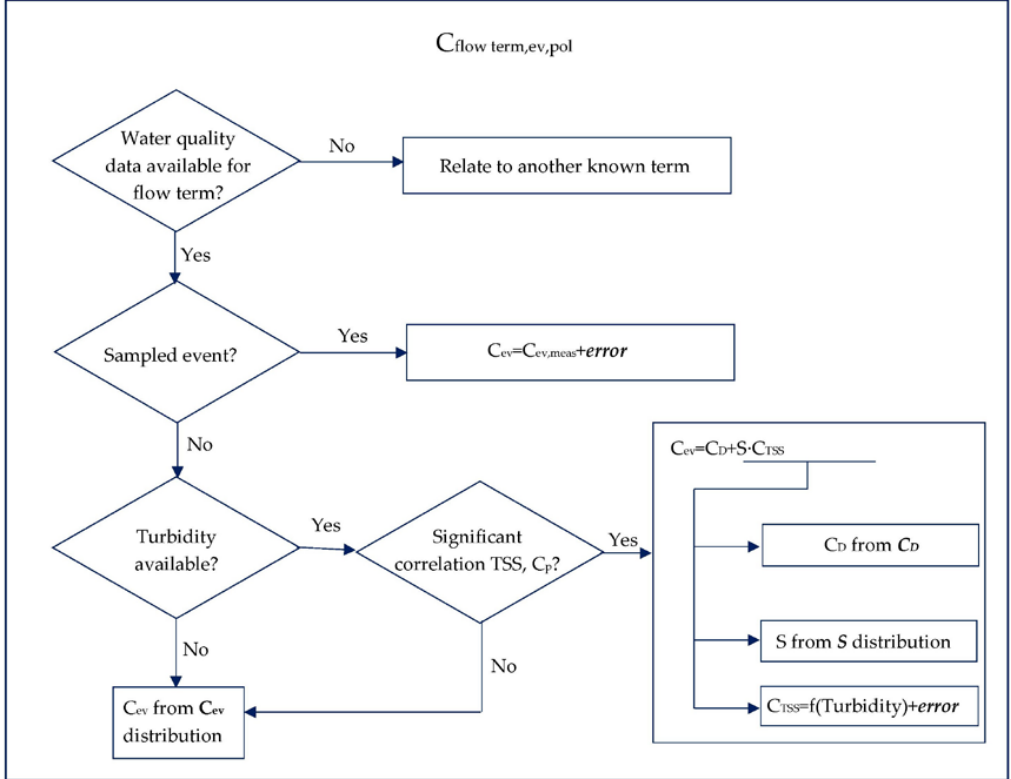
Figure 4. Generalized method for evaluating concentrations associated with each flow term.